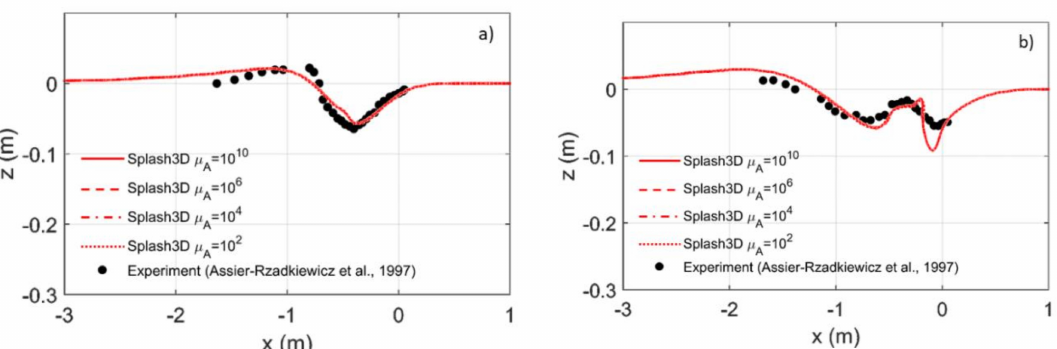
Figure 6. The comparison of free-surface profiles for di ff erent un-yield viscosity µ A in the Bingham model. Di ff erent lines represent di ff erent values of µ A . The dots indicate the experimental results from Assier Rzadkiewicz at: ( a ) t = 0.4 s and ( b ) t = 0.8 s.